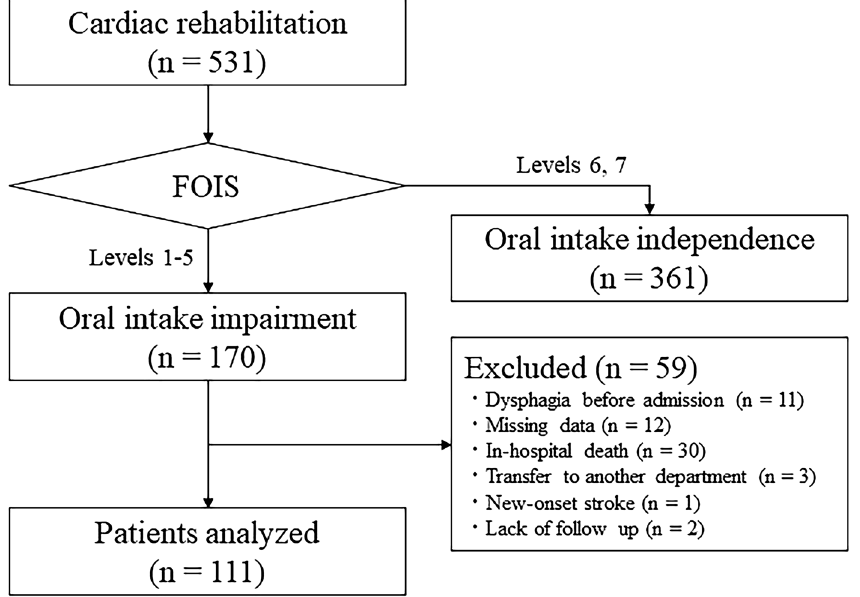
Figure 1. Flow diagram depicting patient selection for this study. In this study, 531 patients who received cardiac rehabilitation were classified into the oral intake impairment and non-oral intake impairment groups in accordance with their FOIS scores at rehabilitation initiation. FOIS: functional oral intake